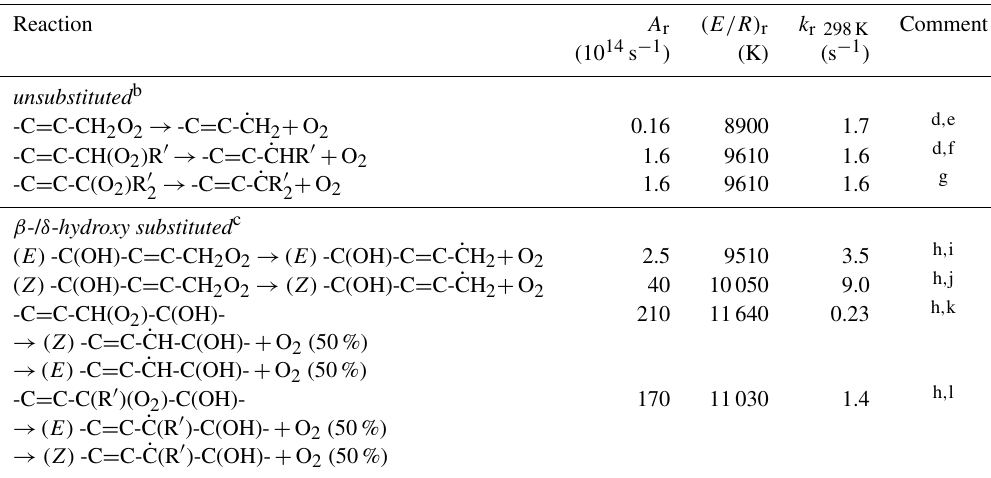
Table 18. Arrhenius parameters ( k r = A r exp( − (E/R) r /T )) for the rate coefficients for the decomposition of allyl peroxy radicals; and the rate coefficient values at 298K a